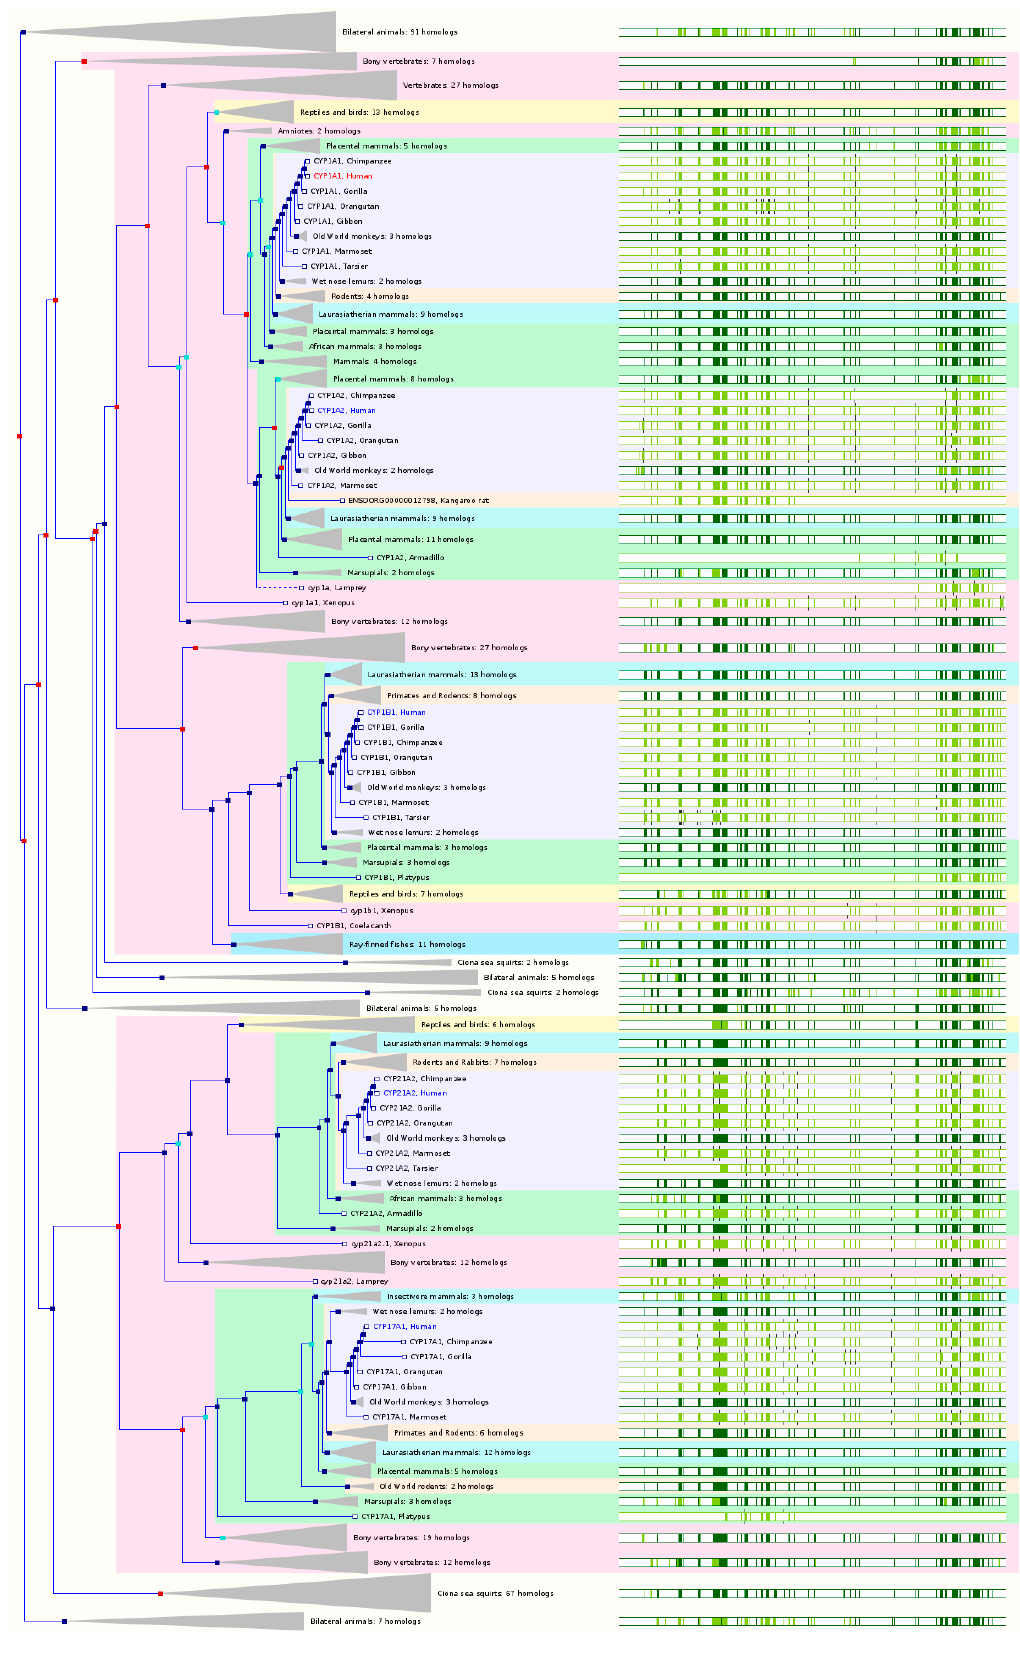
Figure 2. Cont . Figure 2.